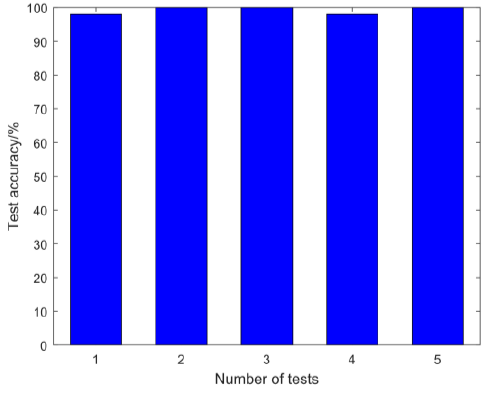
Figure 17. Average recognition precision of different training and test sample set ratios.